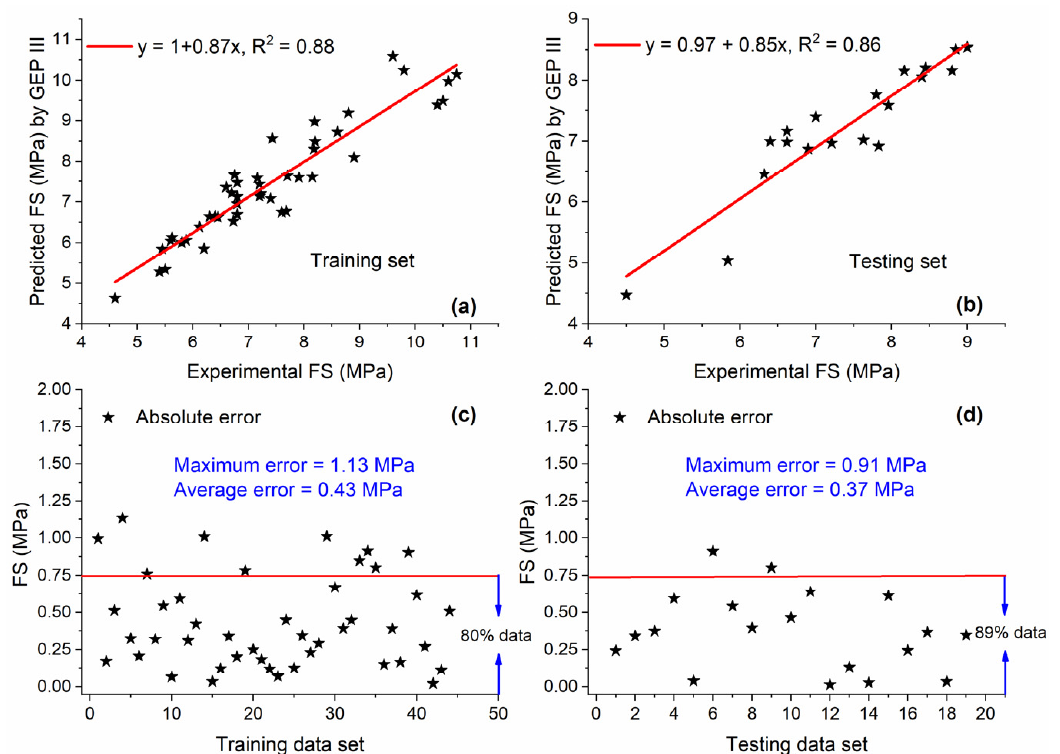
Figure 19. Experimental and predicted values of FS by GEP III for ( a ) training set and ( b ) testing set, and their corresponding absolute error for ( c ) training data set and ( d ) testing data set.